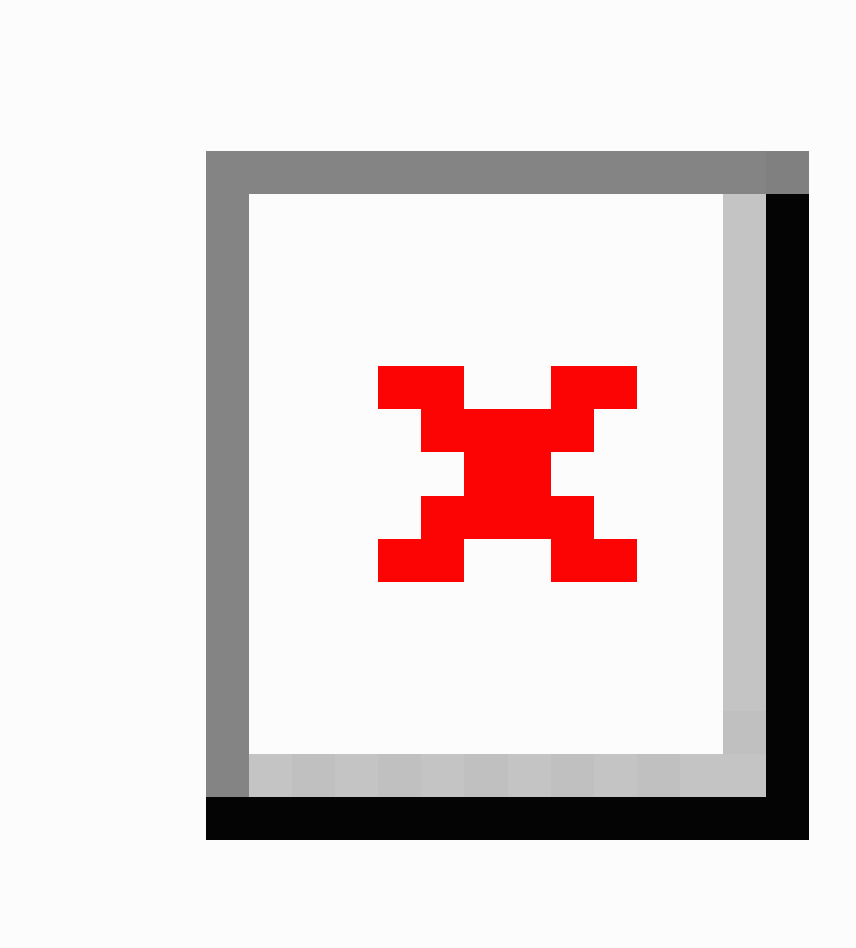
Figure 6. New cloud model data matching